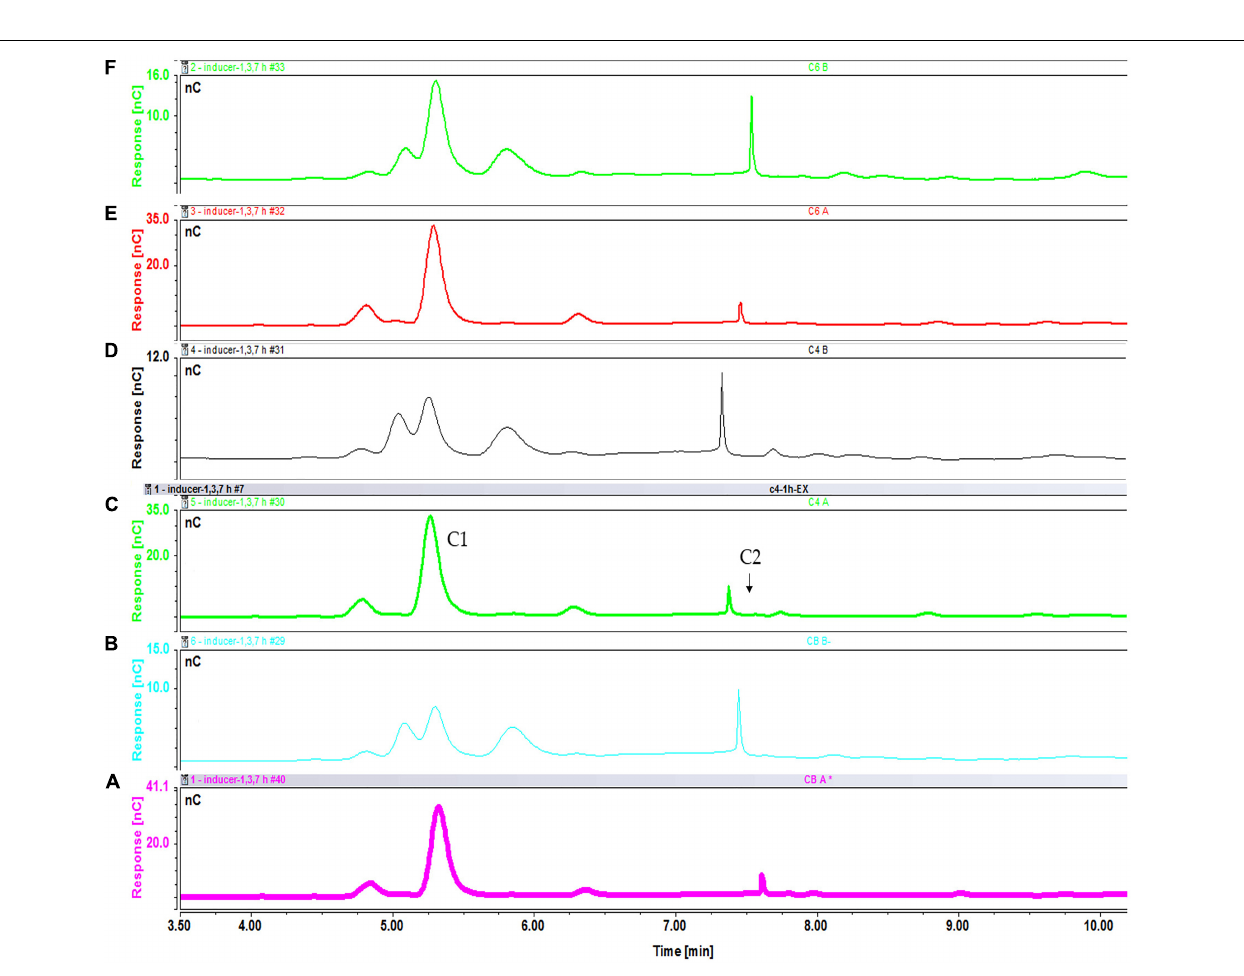
Frontiers in Microbiology |